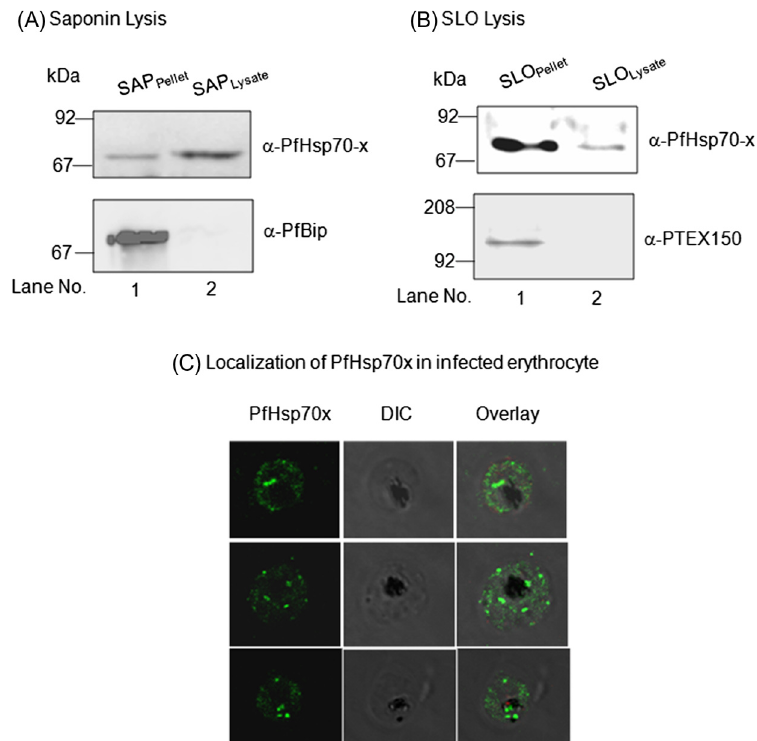
Figure 5. Sub-cellular localization of PfHsp70-x in infected erythrocyte : Infected erythrocytes were lysed with saponin (A) and SLO (B) and the fractions obtained were analysed by immunoblotting with PfHsp70- x antiserum (top). To ensure that compartmental integrity was maintained during saponin and SLO-based fractionation, the fractions were immunoblotted with PfBip and PTEX150 respectively (below). PfHsp70- x gets exported outside the parasite with major population being present in the PVand some in the erythrocyte compartment. (C) IFA analysis of infected erythrocytes with PfHsp70- x antiserum reveals its presence throughout the infected